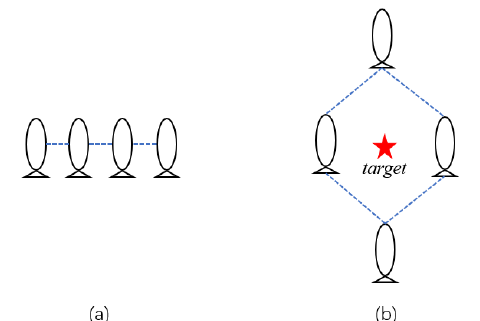
Fig. 2 Formations used for (a) target search and (b) target tracking.